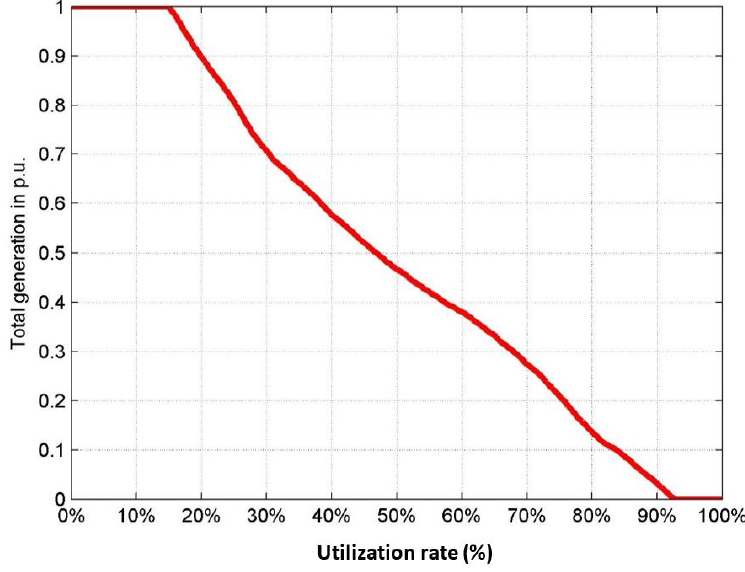
Figure 15. Duration curve when minimizing emissions over one year. Table 2. Utilization rates and operation times for minimizing emissions.